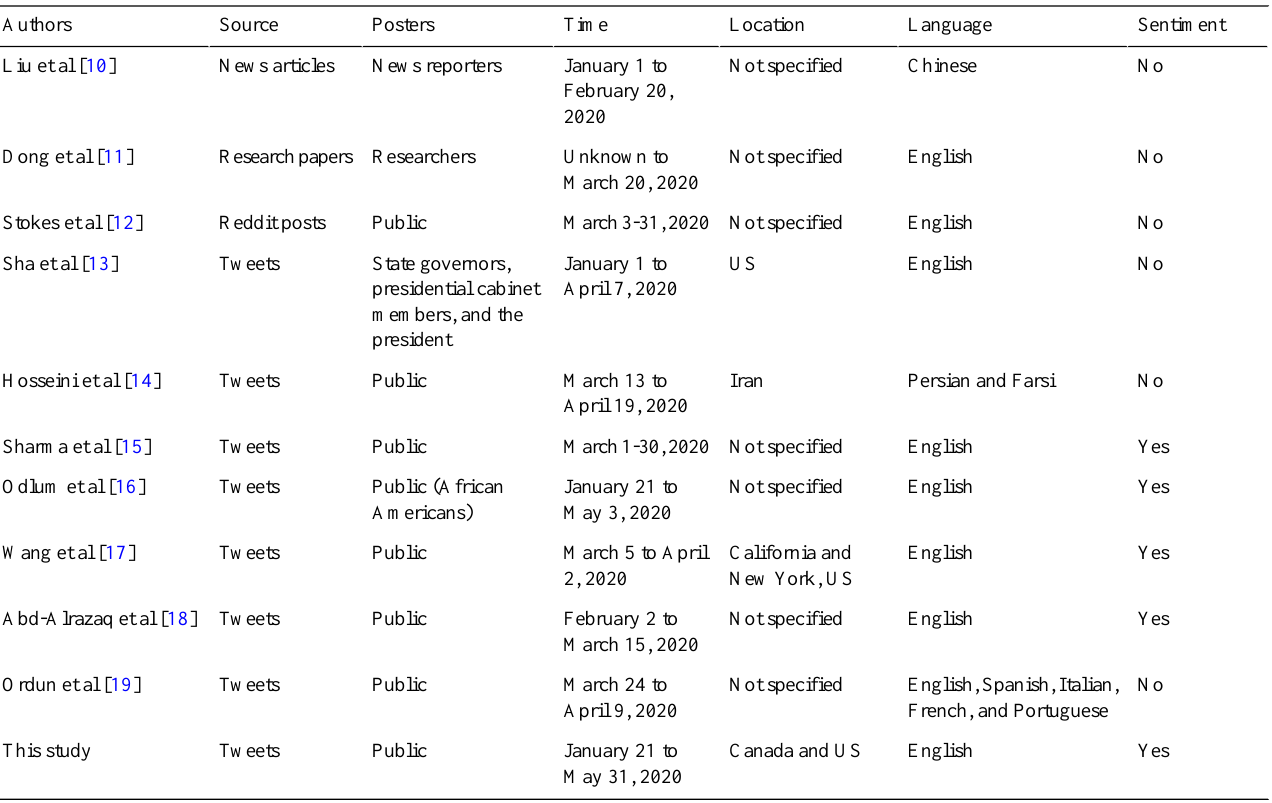
Table 1. Related work on topic modeling and sentiment analysis on COVID-19–related